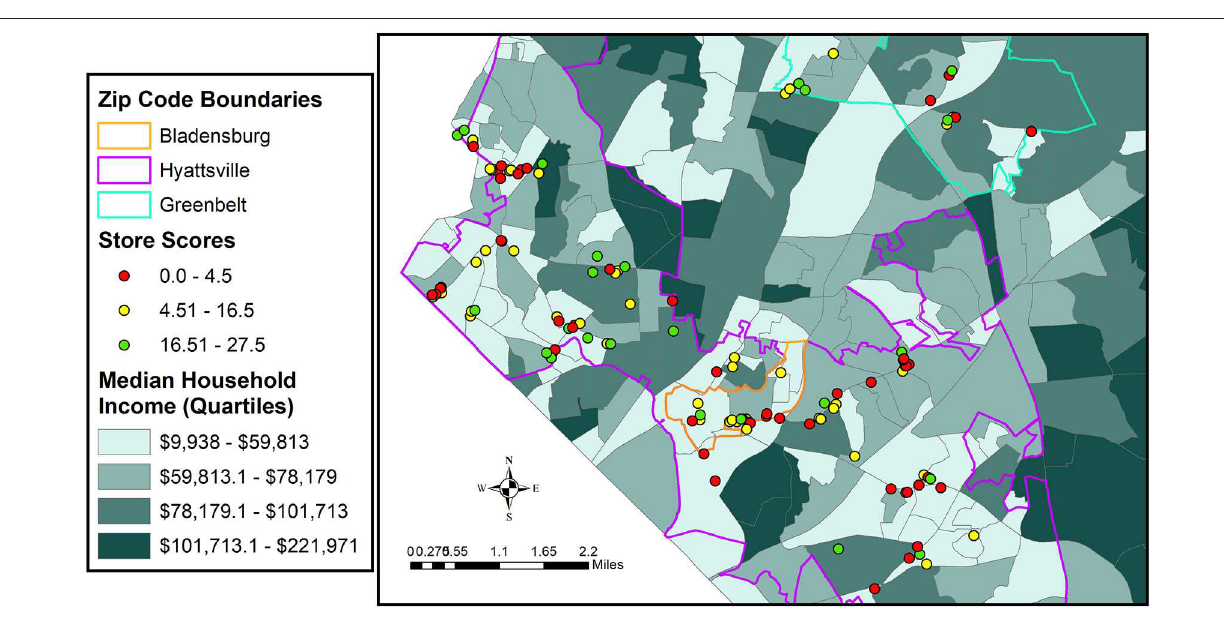
FIGURE 4 | Distribution of HFAI scores across Bladensburg, Greenbelt, and Hyattsville, MD